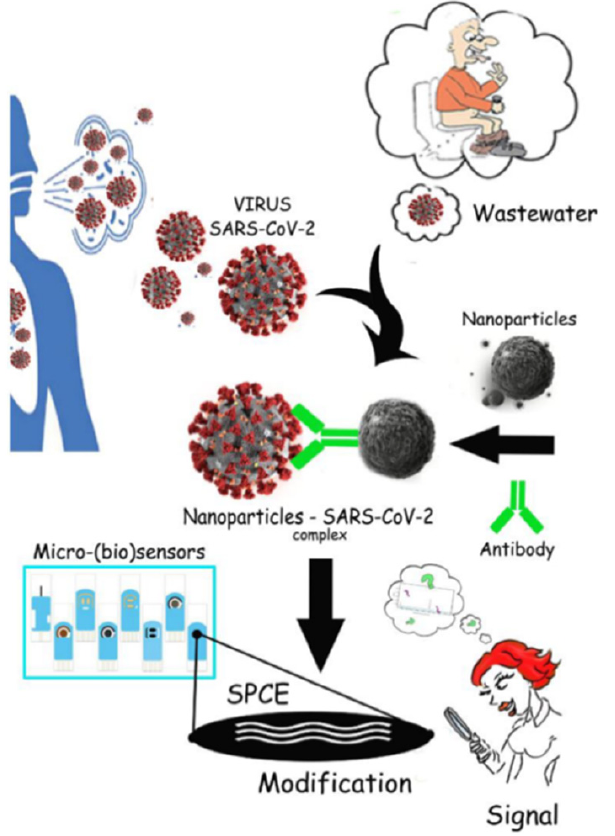
Figure 2. The usage of biosensors in sewerage system.